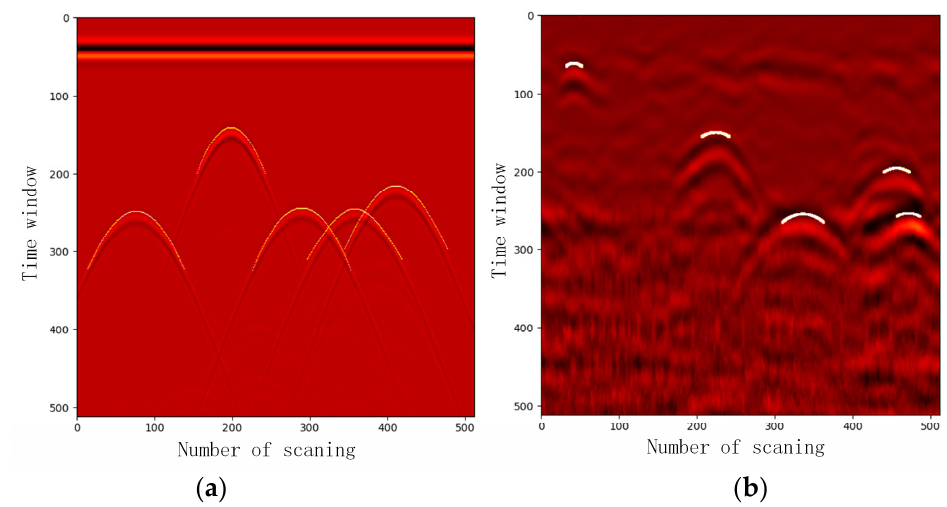
Figure 19. The fitting hyperbola on the synthetic and field data. ( a ) Hyperbola fitting result on the